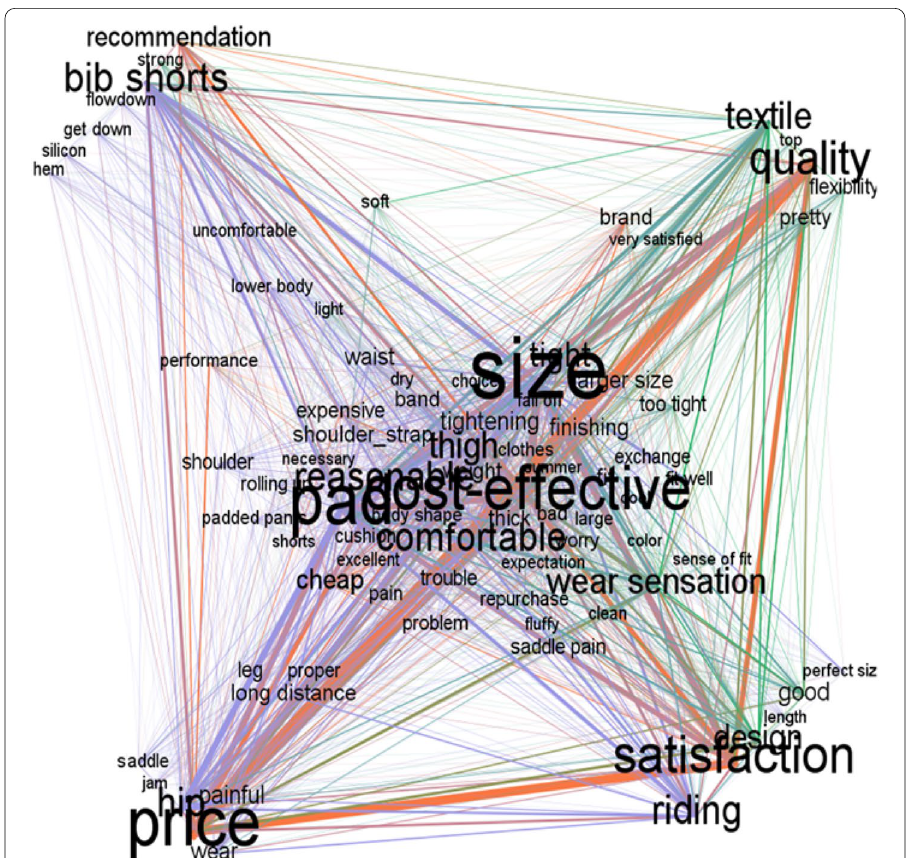
Fig. 6 Visualization of network analysis using co-occurrence